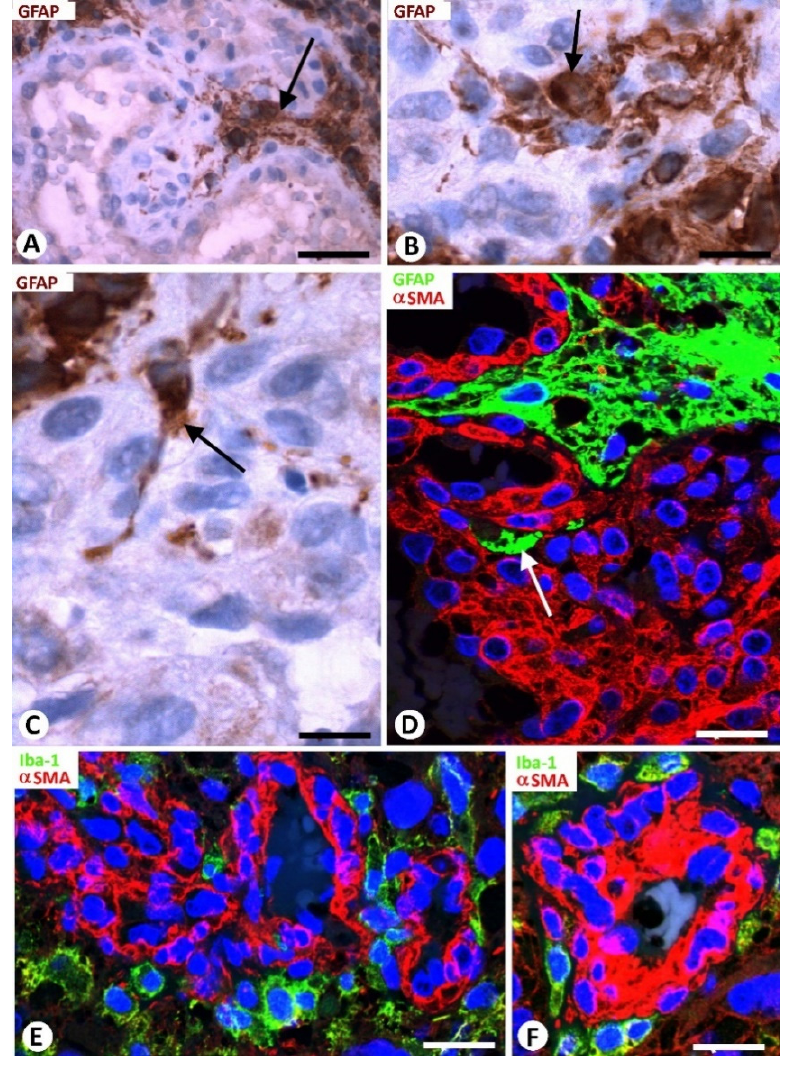
Figure 3. Relationship of neoplastic glial cells ( A – D ) and microglia ( E , F ) with bizarre vessels in GBM. ( A – D ) Images of occasional neoplastic glial cells (brown in ( A – C ); green in ( D ), arrows) incorporated between glomeruloid body components (hematoxylin-stained nuclei in ( A – C ) and α SMA+ pericytes (red) in ( D )). ( E , F ) Microgliocytes with an ameboid aspect (green) are observed around pericytes (red) of bizarre vessels. ( A – C ) Immunochemistry for GFAP (brown). Hematoxylin counterstain. ( D ) Double immunofluorescence for GFAP (green) and α SMA (red). DAPI counterstain. ( E , F ) Double immunofluorescence for Iba1 (green) and α SMA (red). Bar: ( A ) 40 µm, ( B , C ) 15 µm, and ( E , F ) 30 µm . Isolated Iba1 + microglial cells were observed in areas adjacent to the BM in GBM using double immunofluorescence for Iba1 and α SMA (Figure 3E,F). Microgliocytes showed an increased body, with an amoeboid aspect.